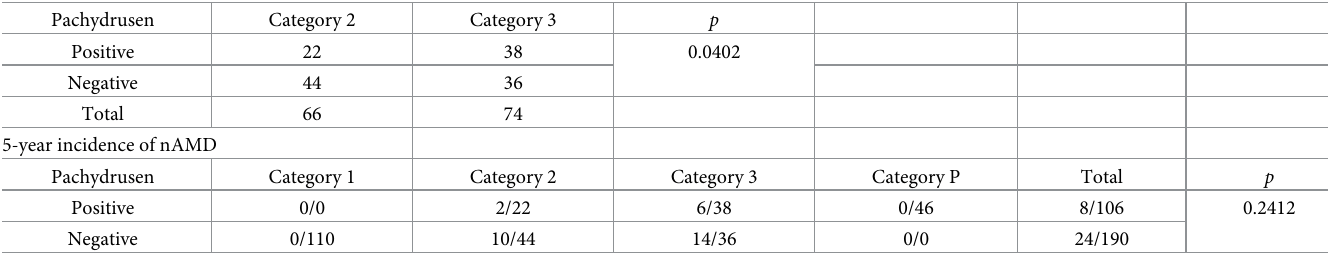
Table 4. The prevalence of pachydrusen in Category 2/3 and 5-year incidence of nAMD in the presence or absence of pachydrusen.